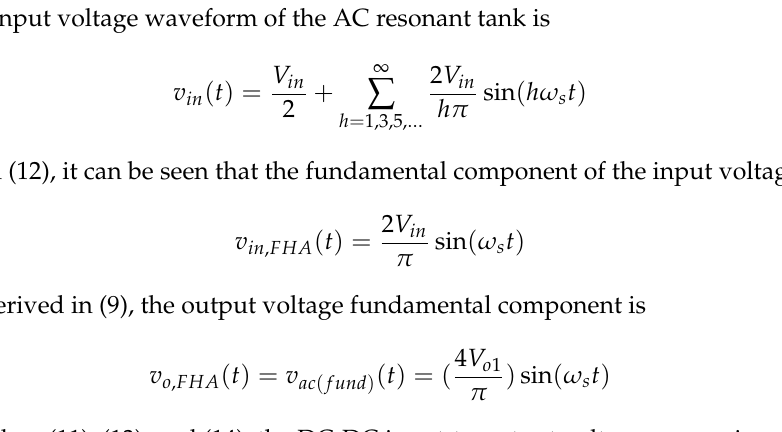
Figure 7. Two-port model of the FHA resonant circuit.